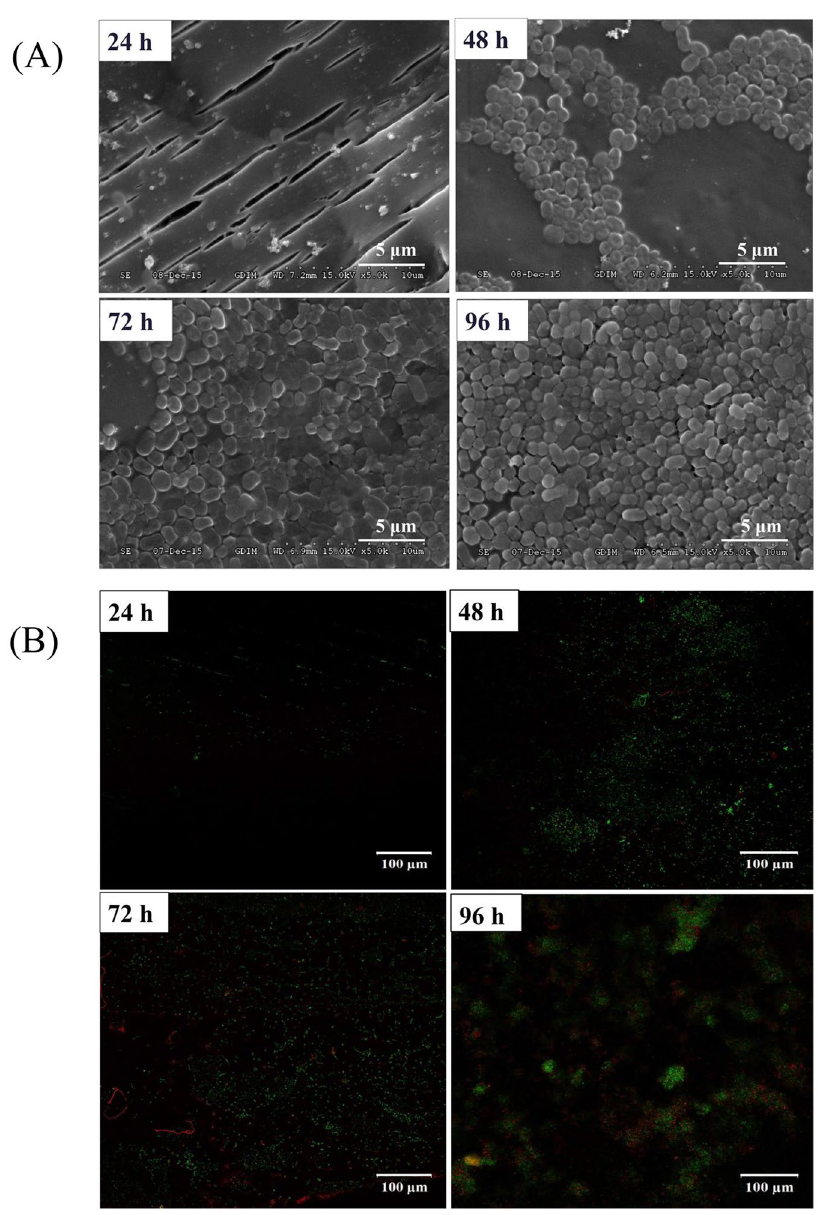
Figure 1. Growth of an Acinetobacter sp. DW-1 biofilm on polyhedron hollow polypropylene balls visualized by scanning electron microscopy ( A ) and confocal laser scanning microscopy ( B ).